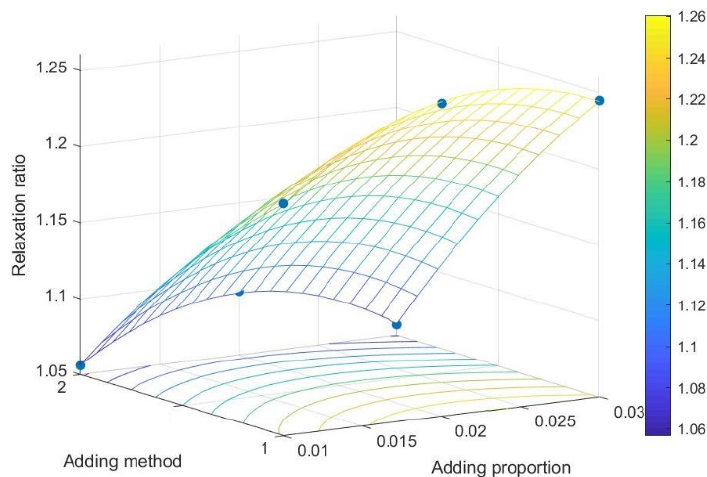
Figure 6. Chart of factor significance.